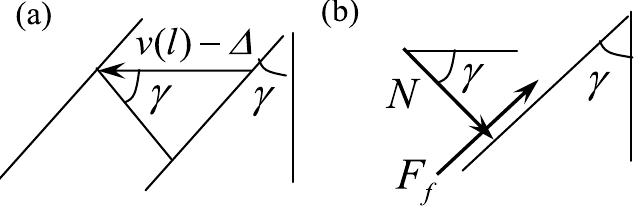
Fig. 2. The geometrical relations of the displacements (a) and forces (b) on the contact